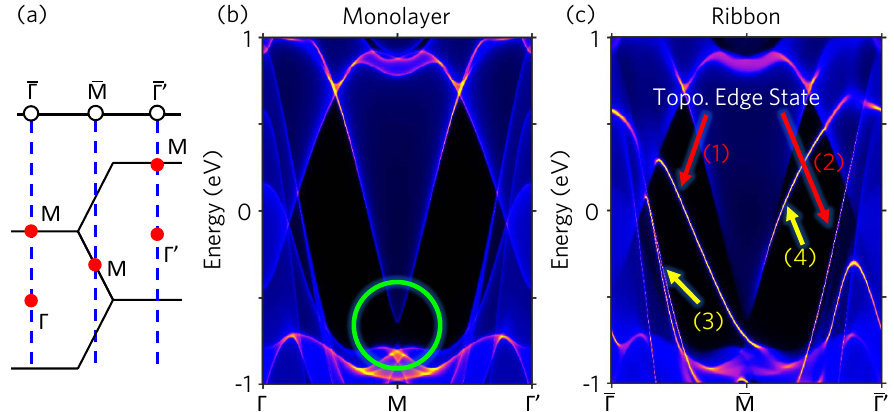
Figure 3. ( a ) 2D and 1D Brillouin zone of 1 T − VSe 2 monolayer and ribbon at the (010) edge, respectively. The blue dash lines indicate the relation between the high symmetry k − points in the 2D and 1D BZ. ( b ) Band structure of 1 T − VSe 2 monolayer from the semi-infinite Green functions method. ( c ) Band structure of 1 T − VSe 2 ribbon from the semi-infinite Green functions method. In comparison with ( b ), four edge states (bright yellow curves) can be identified. Two of them are topological edge states as indicated by the red arrows (1) and (2). The other two edge states are topologically trivial as indicated by yellow arrows (3) and